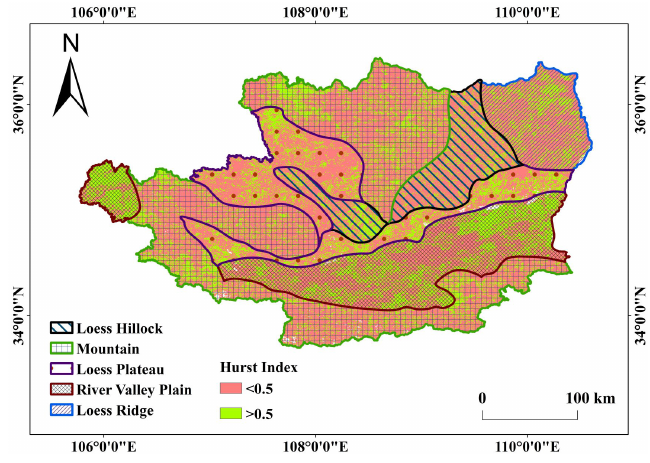
Figure 19. Hurst index map.